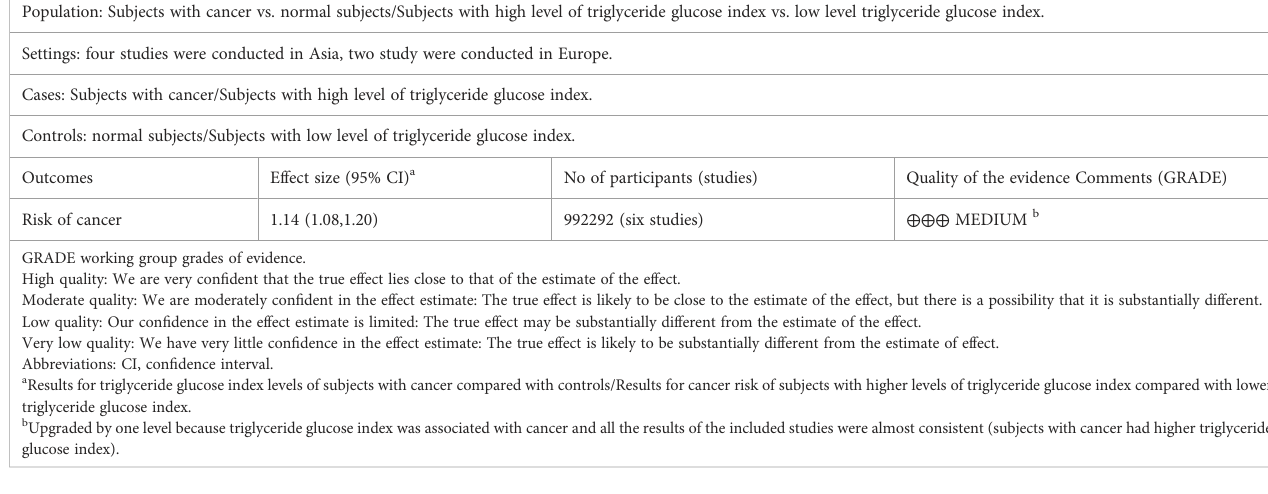
TABLE 2 The Summary of Findings (SoF) with GRADE system. Risk of cancer with different triglyceride glucose index levels.